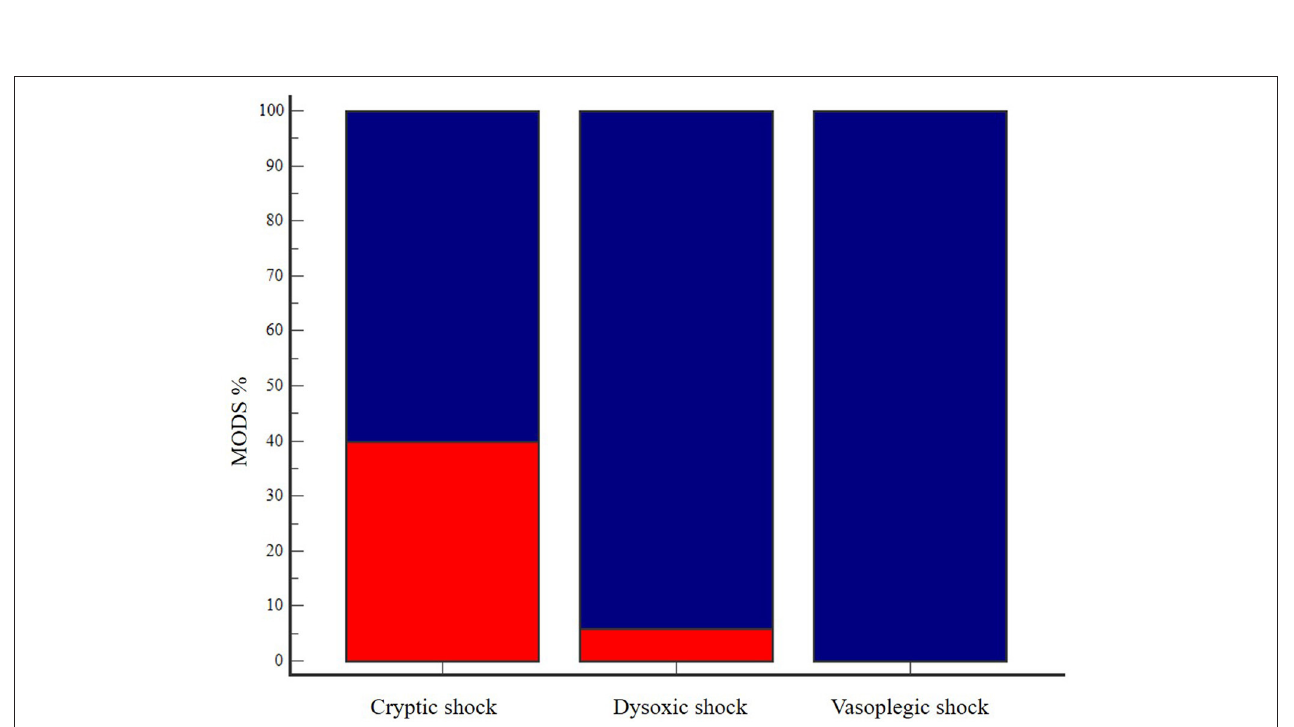
FIGURE 3 | Bar chart with 100% stacked columns showing the percentage in MODS occurrence (in dark blue) in cats with cryptic shock ( n = 7, 57%), dysoxic shock ( n = 17, 94%) and vasoplegic shock ( n = 11, 100%). The difference was statistically significant ( P = 0.02). MODS, multiorgan dysfunction syndrome.